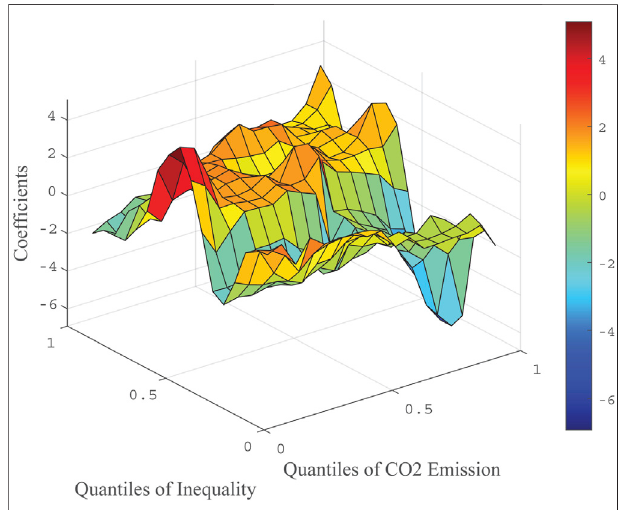
FIGURE 3 | The impact of income inequality on carbon emissions